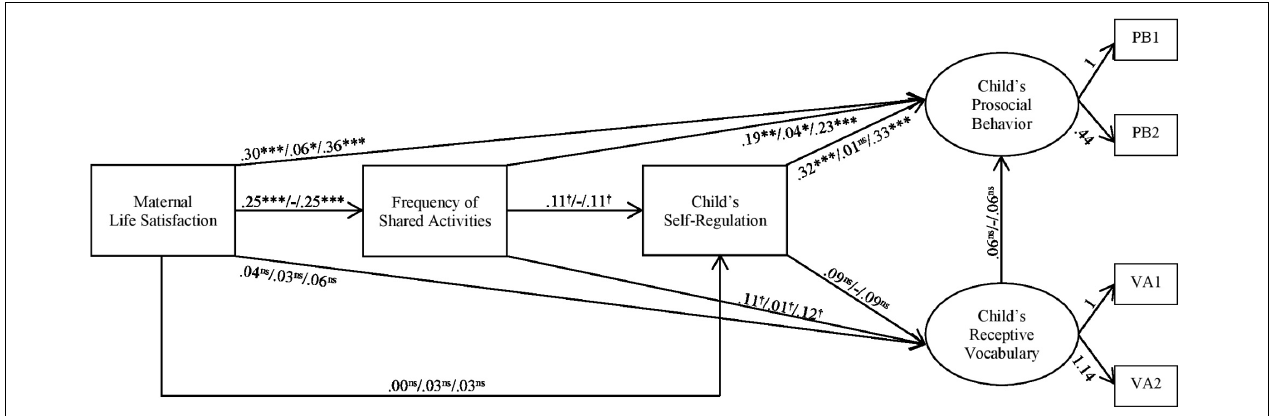
FIGURE 2 | Structural model predicting the latent factors prosocial behavior and receptive vocabulary from the manifest variables self-regulation, frequency of shared parent-child activities, and maternal life satisfaction without control variables. Printed path estimates are standardized β -coefficients in the following order: direct effect/indirect effect/total effect; † p < 0.1, ∗ p < 0.05, ∗∗ p < 0.01, ∗∗∗ p < 0.001. N = 291 mother-child